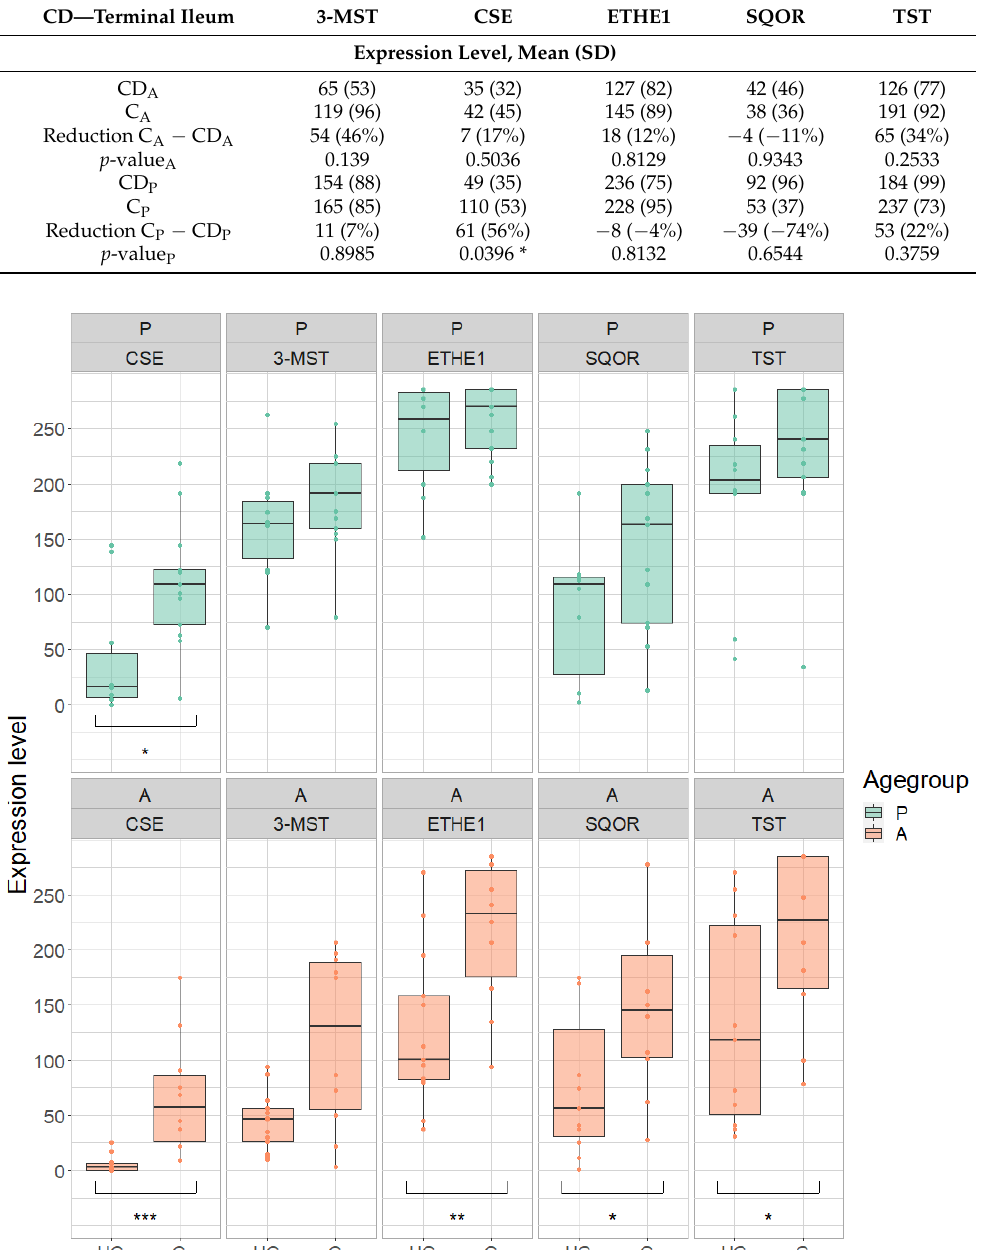
Figure 9. Expression of cystathionine- γ -lyase (CSE), 3-mercapto-sulfurtransferase (3-MST), ethylmalonic encephalopathy 1 protein (ETHE1), sulfide:quinone oxidoreductase (SQOR) and thiosulfate sulfurtransferase (TST) in pediatric (P) and adult (A) samples in the rectum of ulcerative colitis (UC) compared to healthy controls (C). Range of expression levels from a minimum of 0 to a maximum of 300. * = p -value < 0.05, ** = p -value < 0.01, *** = p -value < 0.001.